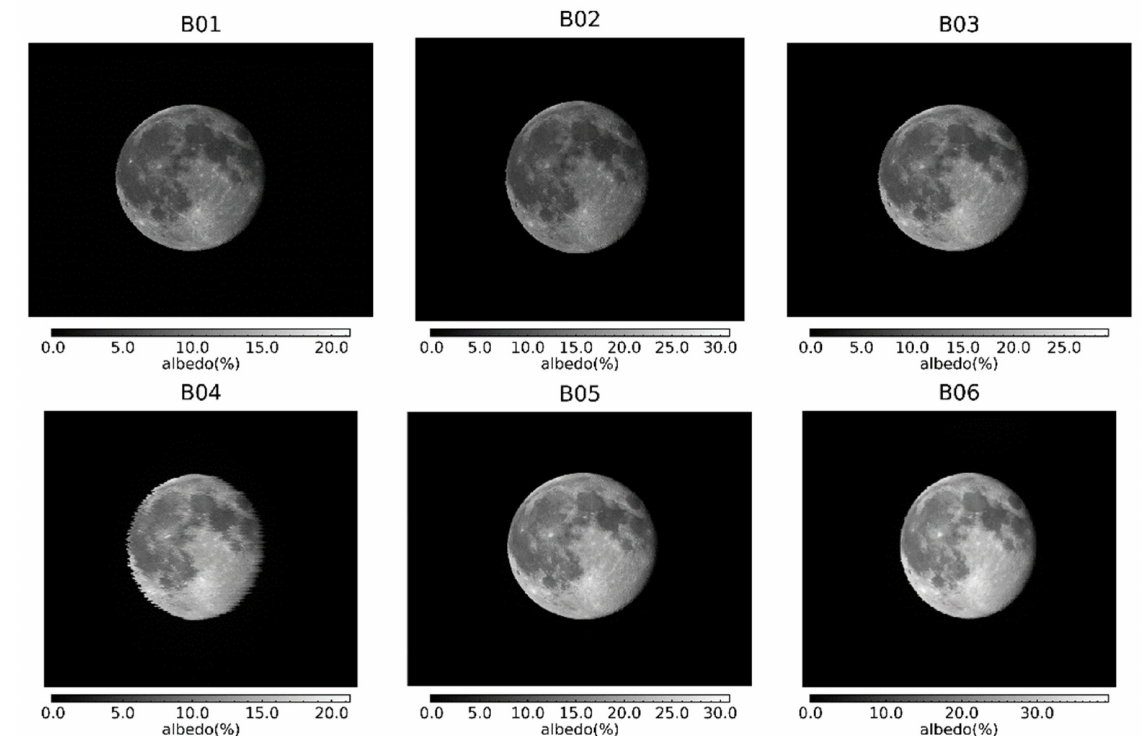
Figure 4. Subset GOES-16 ABI VNIR lunar images collected on 12 April 2017. The subsets are of comparable sizes in angle, with the number of samples in the B02 image about 2 × 2 times of that for B01, B03 and B05 and 4 × 4 times of that for B04 and